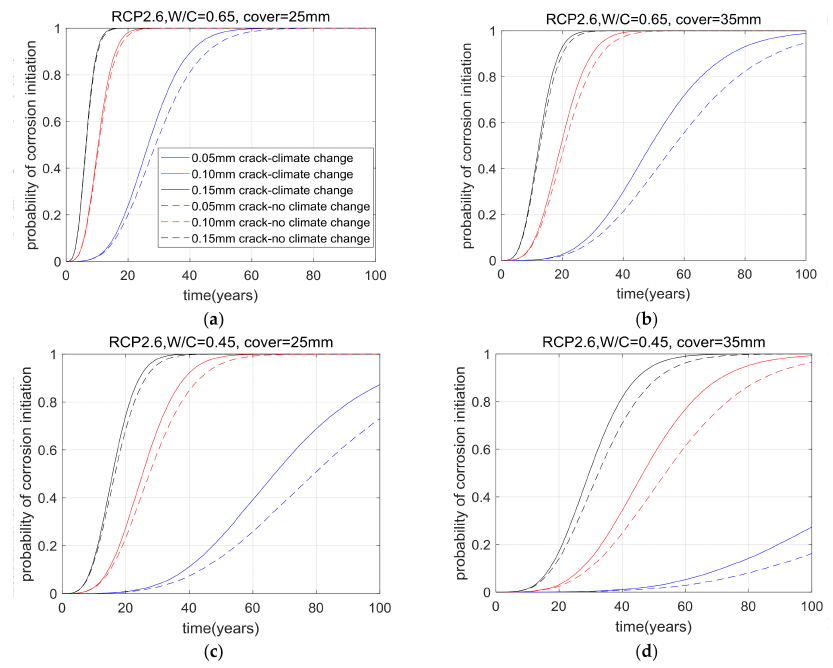
Figure 10. Probability of corrosion initiation-RCP 2.6, time slice 2000. ( a ) W/C: 0.65, Cover depth: 25 mm; ( b ) W/C: 0.65, Cover depth: 35 mm; ( c ) W/C: 0.45, Cover depth: 25 mm; ( d ) W/C: 0.45, Cover depth: 35 mm.